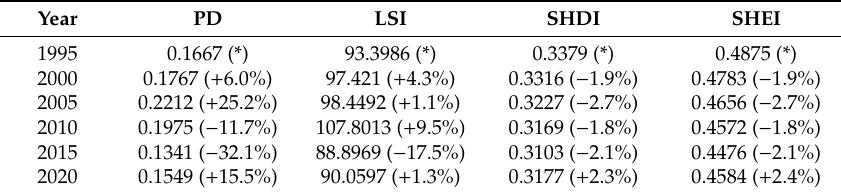
Table 7. Patch density (PD), landscape shape index (LSI), Shannon’s Diversity Index (SHDI) and Shannon’s Evenness Index